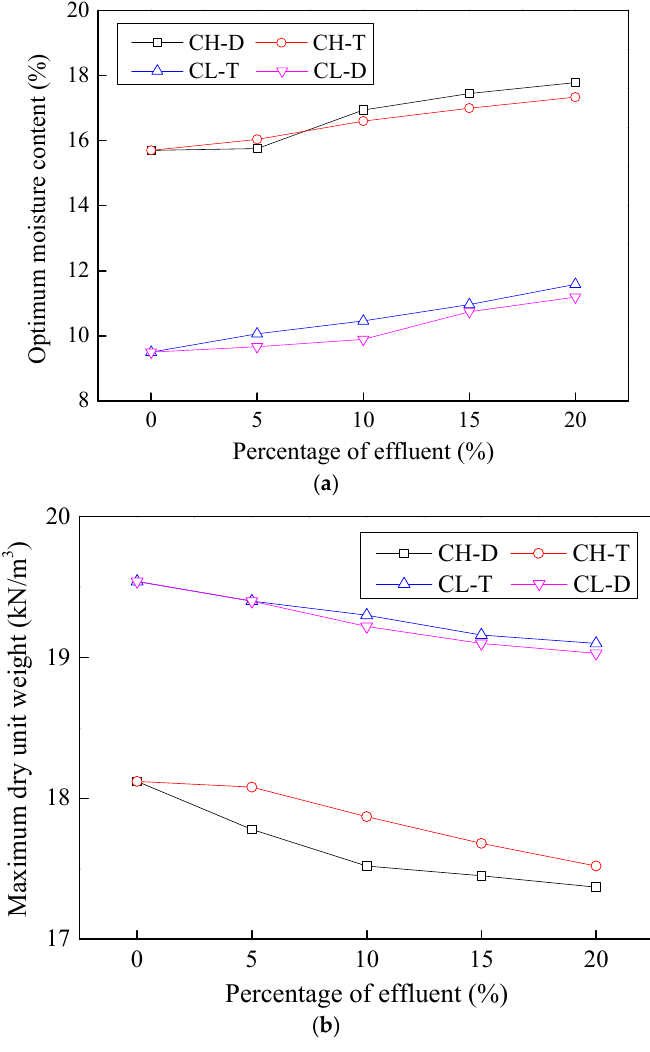
Figure 9. Effects of industrial effluents on the compaction characteristics of the cohesive soils; ( a ) Optimum moisture content, ( b ) Maximum dry density.